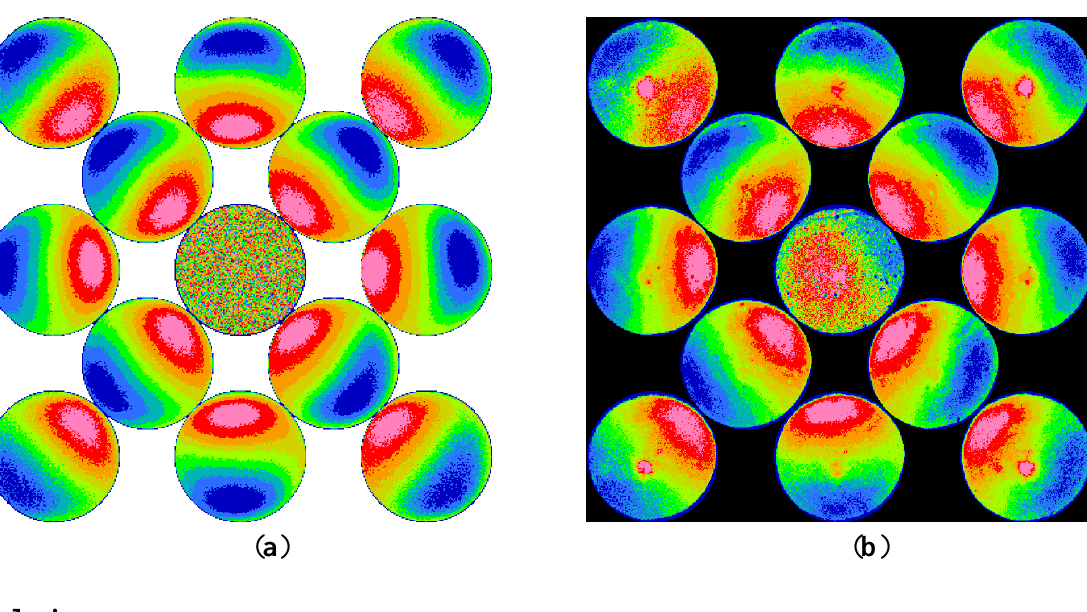
Figure 11. ( a ) Computer simulation result of infrared retinoscopy measurement on a 42 year-old normal eye that had LASIK procedure 5 years before. The manifest refraction of this eye was measured as −1.00DS + 0.75X105 (20/20). The pupil diameter of the wavefront data is 6.75 mm, which is large enough to show clearly the spherical aberration in the periphery. ( b ) The experiment measured image of the same eye. The pupil diameter is about 6.1 mm in this